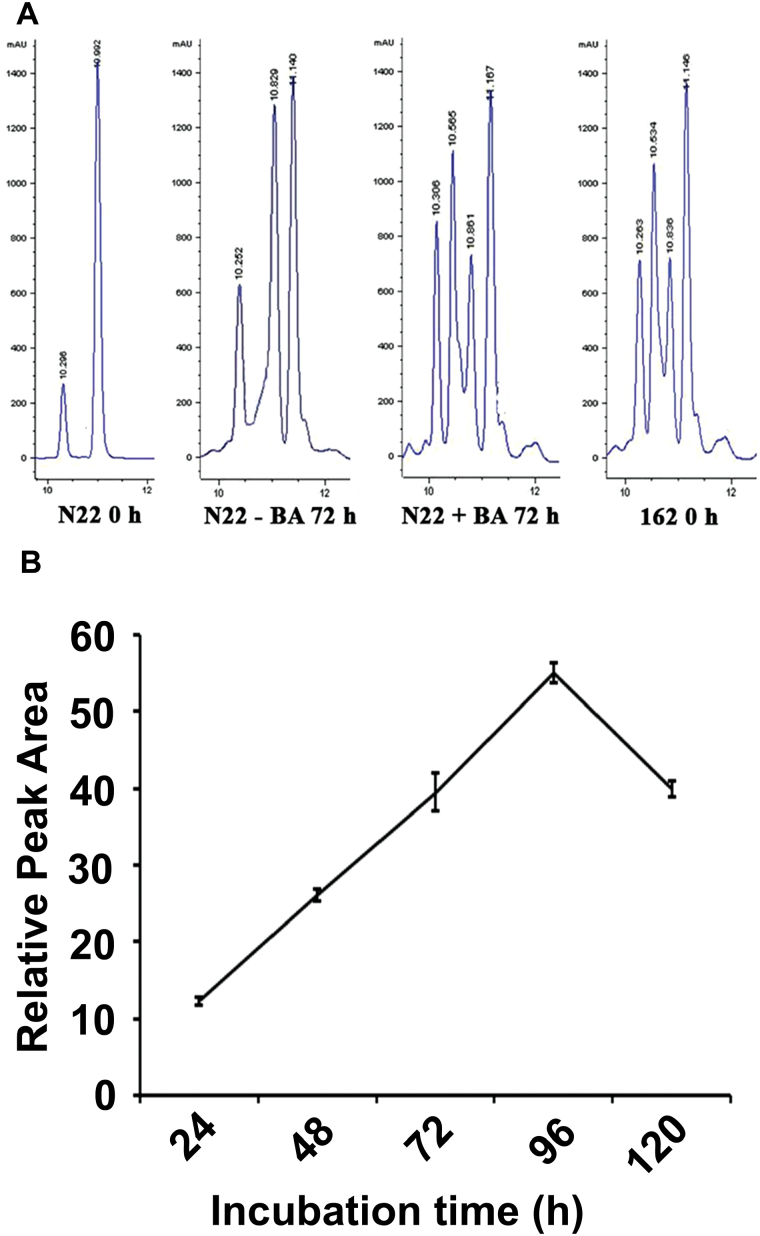
Photosynthetic pigment profiles of rice leaves. (A) HPLC profile of chlorophyll pigments from leaves of 4-week-old rice plants. Total chlorophyll was extracted from cut leaves of N22 before (N22 0h) and after dark incubation for 72h with (N22 +BA) or without (N22 –BA) BA treatment and untreated N22-H-dgl162 (162 0h). Peaks are numbered according to their retention time in minutes. Similar results were reproduced in at least five independent experiments. (B) Kinetics of relative peak area of the additional peak at ~10.5min observed in N22 +BA and N22-H-dgl162 HPLC profiles following 0–120h of dark treatment. Similar results were reproduced in at least three independent experiments.